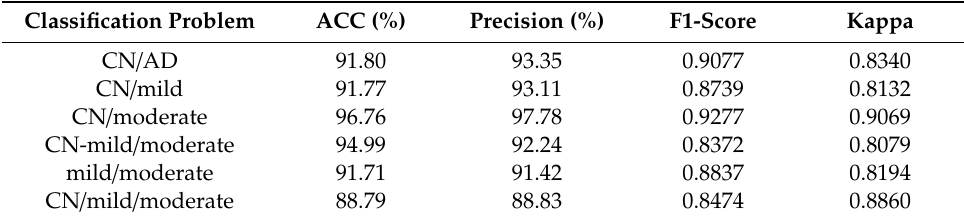
Table 4. The classification results in terms of the Accuracy (ACC), Precision, F1-Score, and Kappa Statistics for a 12-s window